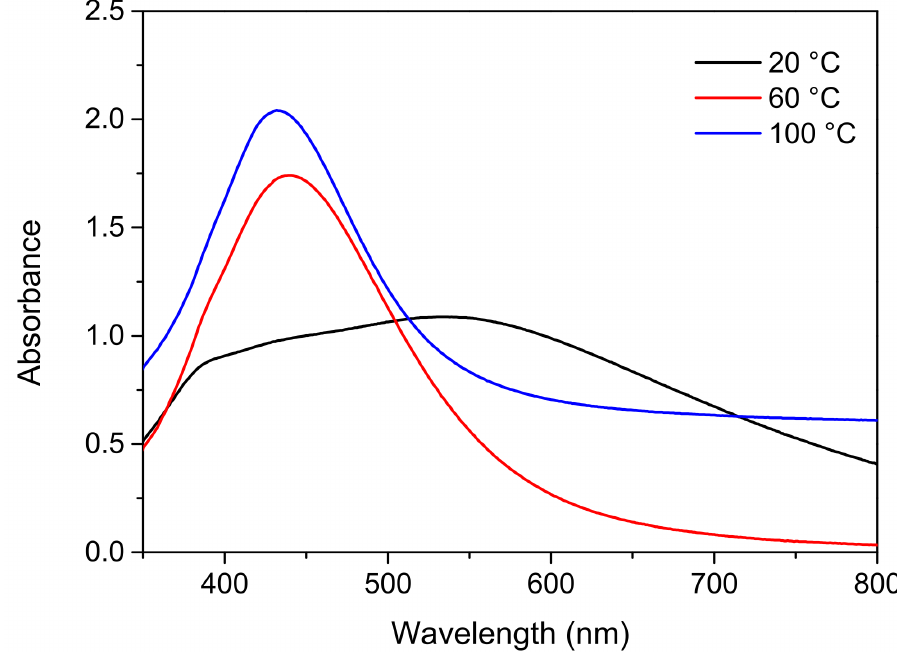
Figure 4. UV-Vis analysis results obtained for samples prepared at various reaction